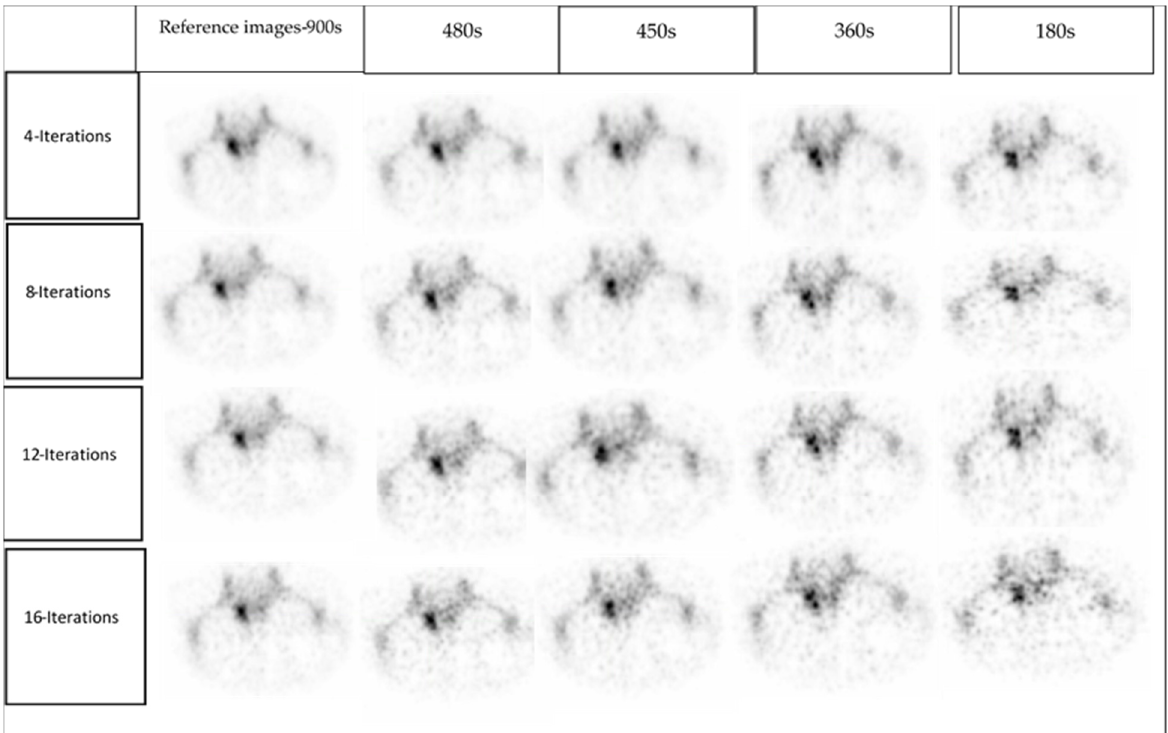
Figure 5. Example for SPECT images at different iteration number in different acquisition time. This patient had Osteoplastic activity in the left Lumbar 1/sacrum 1.